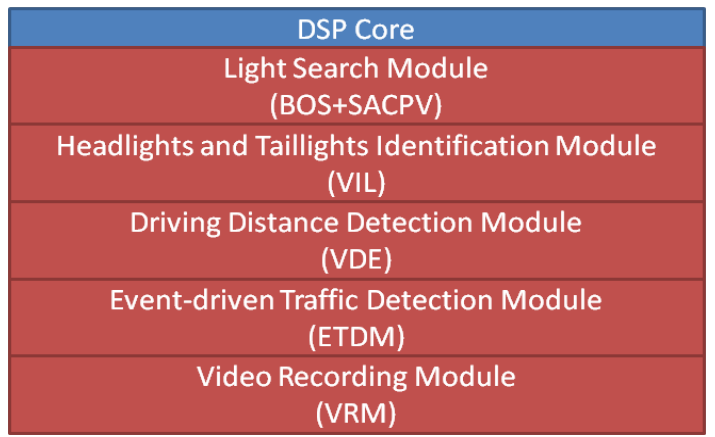
Figure 12. The software architecture of the vision computing modules on the